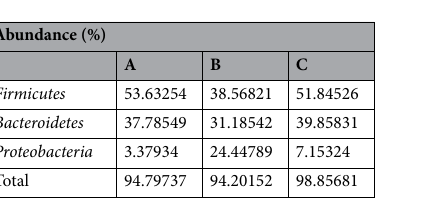
Table 3. The relative abundance of the main gut microbiota at the phylum level in four